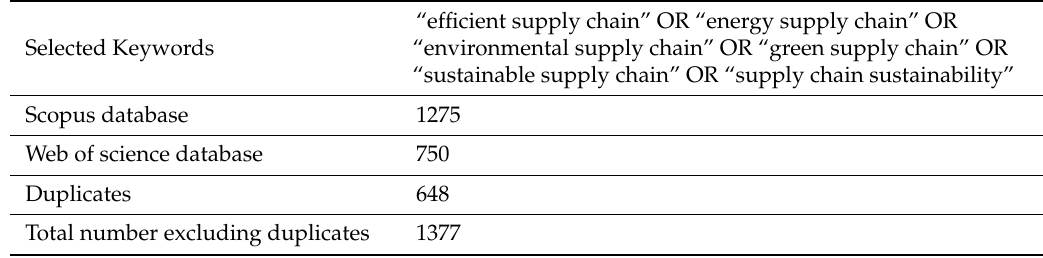
Table 1. Material